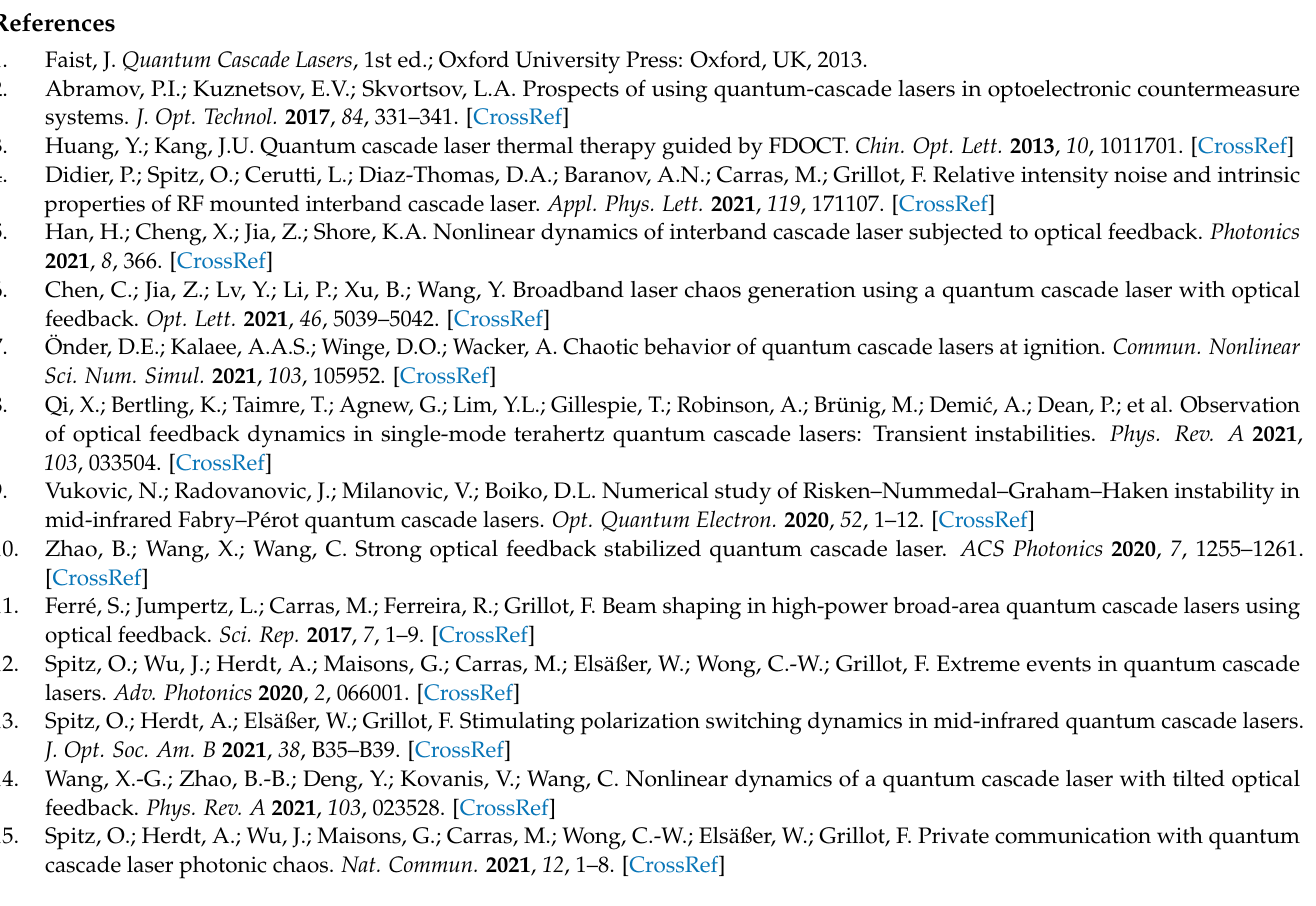
Figure A1. Sketch of the setup used for the determination of the reference feedback ratio. The feedback beam was steered so that it goes above the HHL package, and the optical power was measured with an optical meter. This optical power was compared with that of the free-running QCL. In that latter case, a photopile is placed in front of the output facet of the packaged